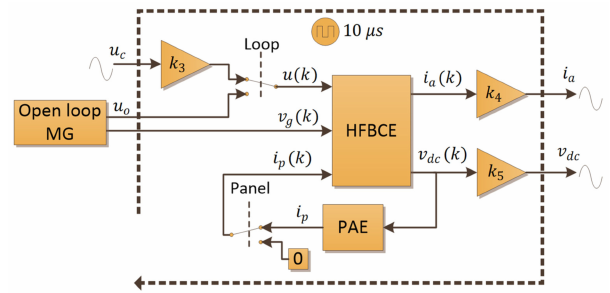
Figure 12. Main grid interconnection system emulator